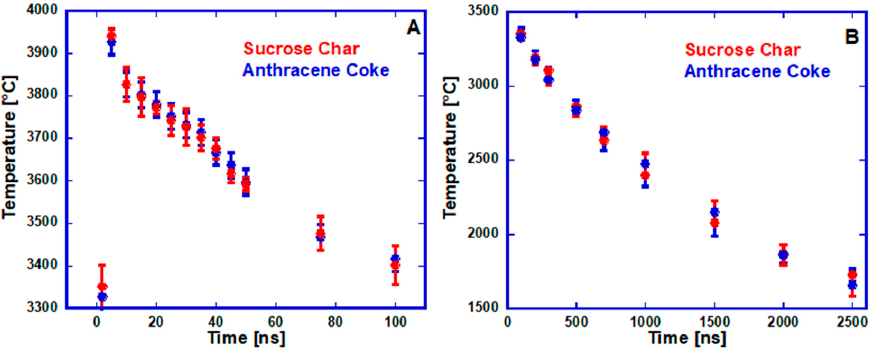
Figure A4. TTH of sucrose char and anthracene coke—200 mJ/cm 2 —( A ) first 100 ns ( B ) post 100 ns.